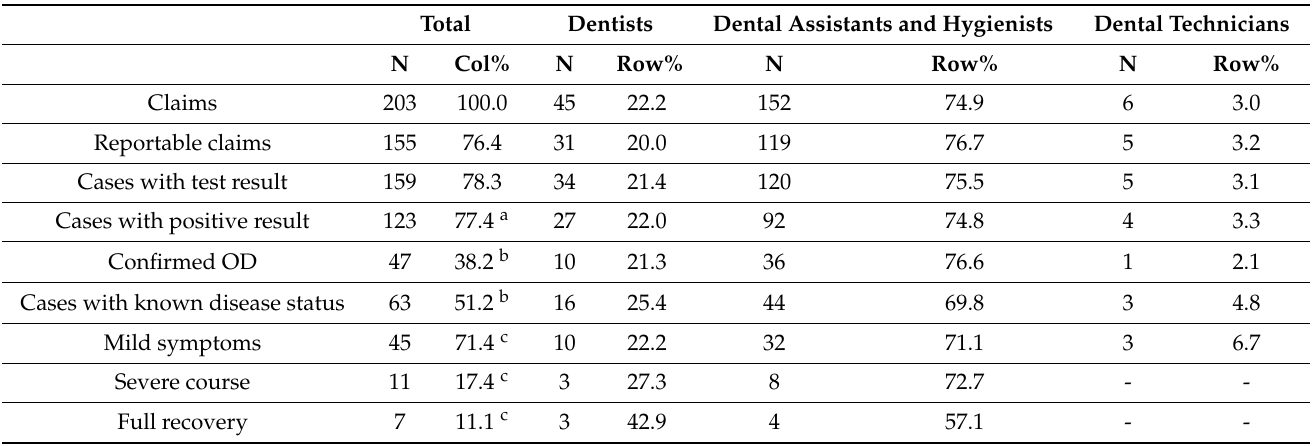
Table 4. Number of claims and confirmed occupational COVID-19 infections among dental health workers from March 2020 to February 2021. OD = Occupational disease.